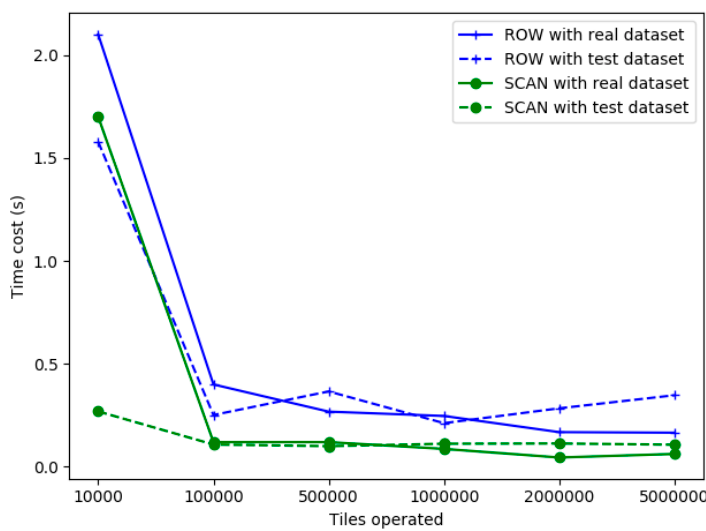
Figure 11. Time cost per tile with 30 m Mosaic data.